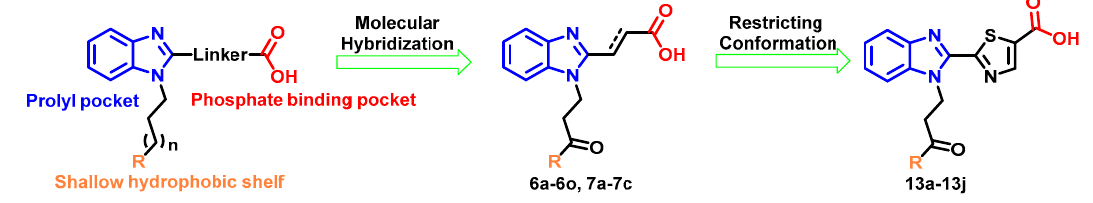
Figure 2. Design strategies of novel Pin1 inhibitors.